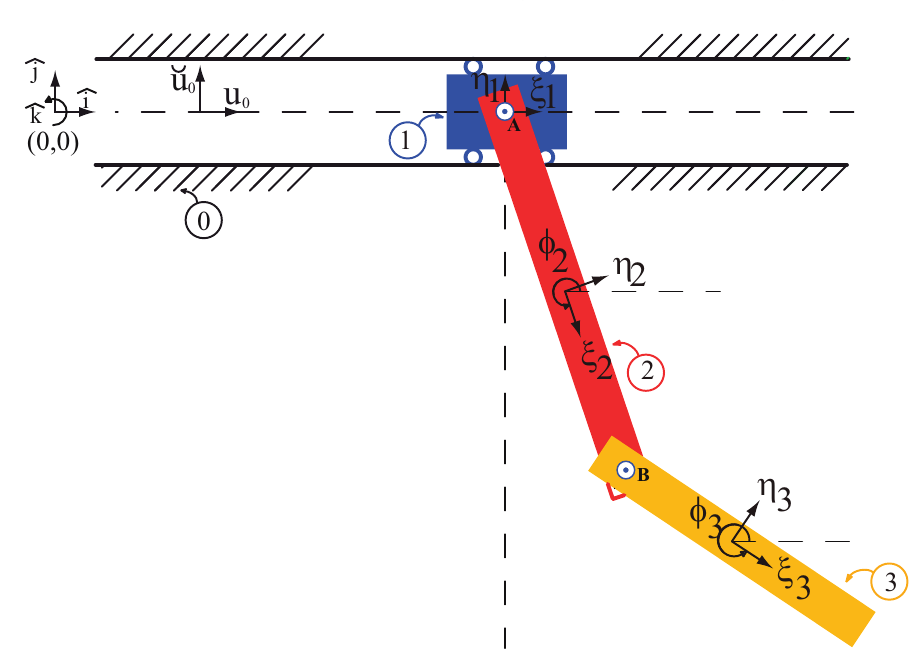
Figure 4. The overhead crane: the trolley plus the two-link payload, modeled as a multibody